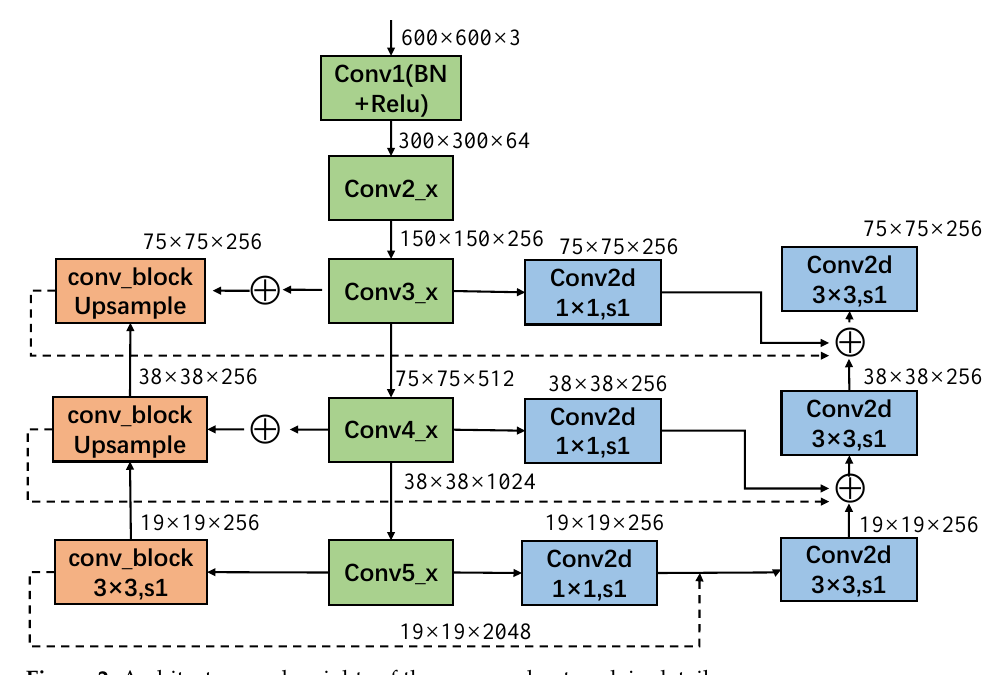
Figure 2. Architecture and weights of the proposed network in